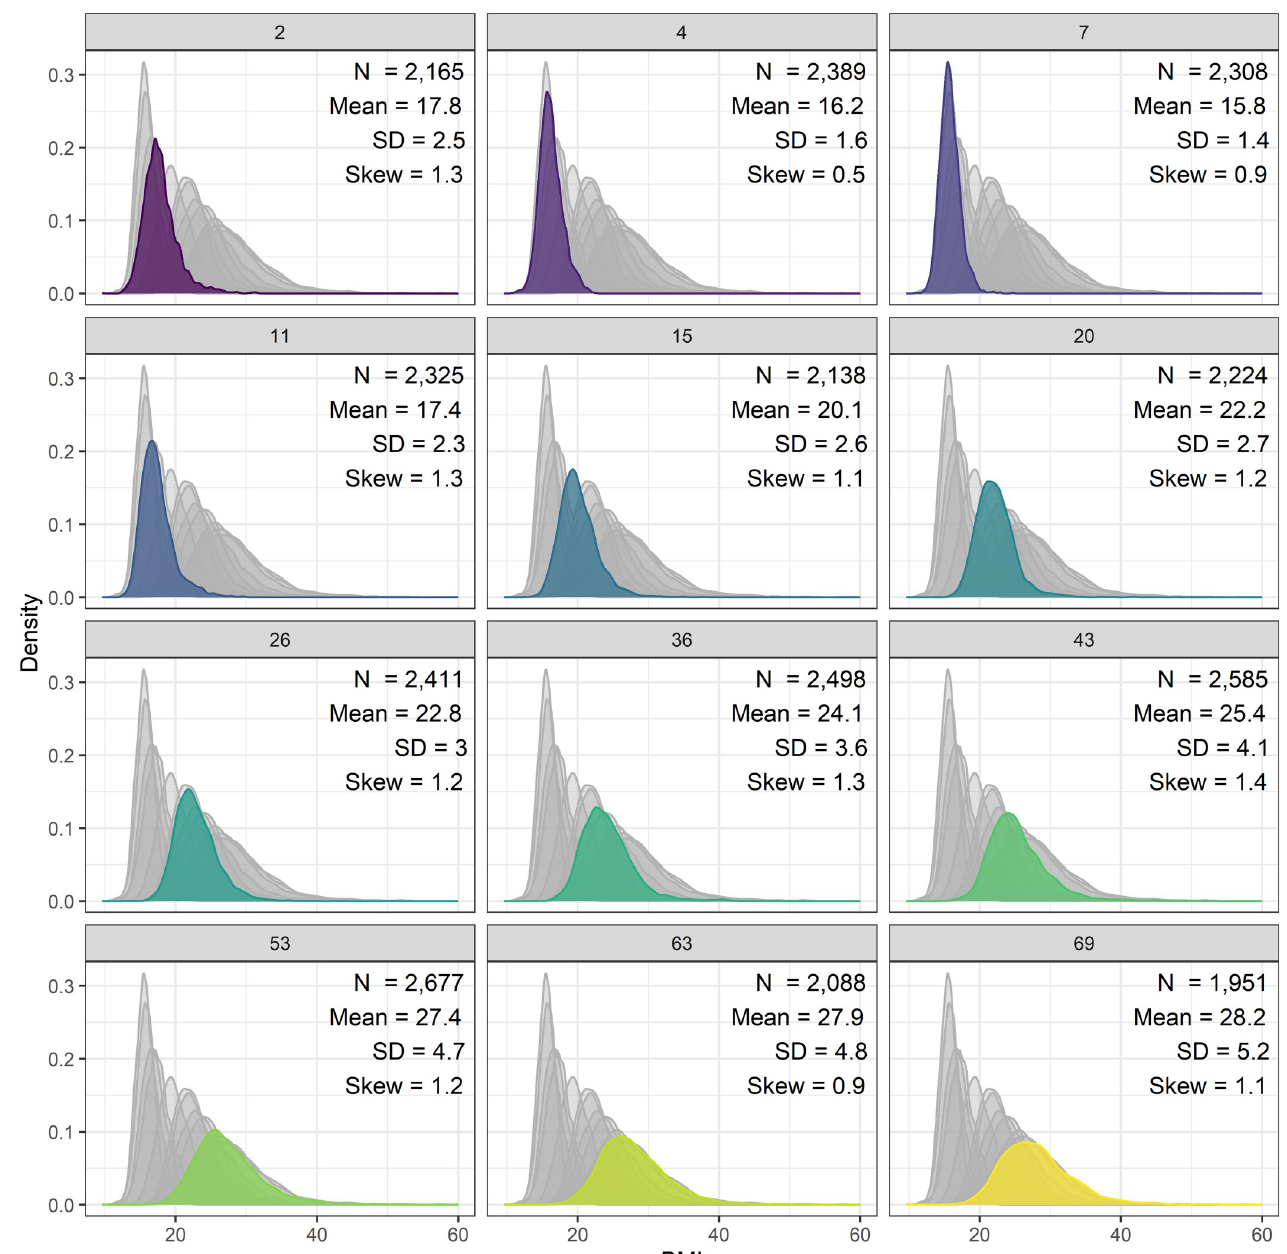
Fig 1. Histograms of body mass index from infancy to old age in the 1946 British birth cohort sample.